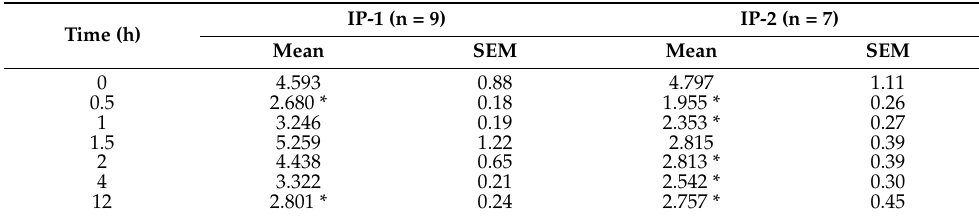
Table 2. F2-IsoPs excretion following IP-1 and IP-2 intake. Mean content ( µ g/gr) ± Standard Error (SEM) is expressed as the sum of 8-isoPGF2 α , ent-PGF2 α , and 2,3-dinor-8-isoPGF2 α . N: sample size; *: significantly different from baseline ( p <